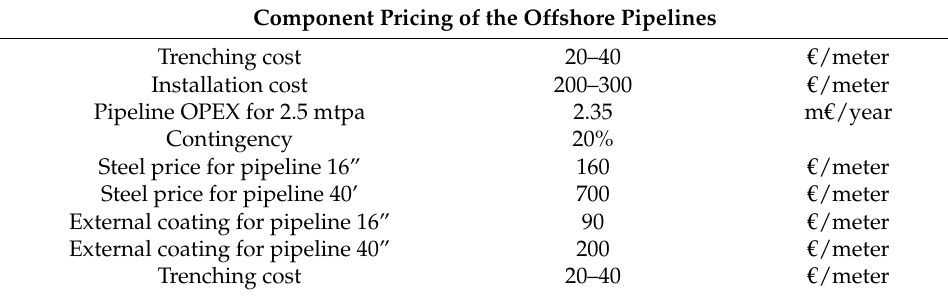
Table 15. Pricing of the offshore pipeline components.